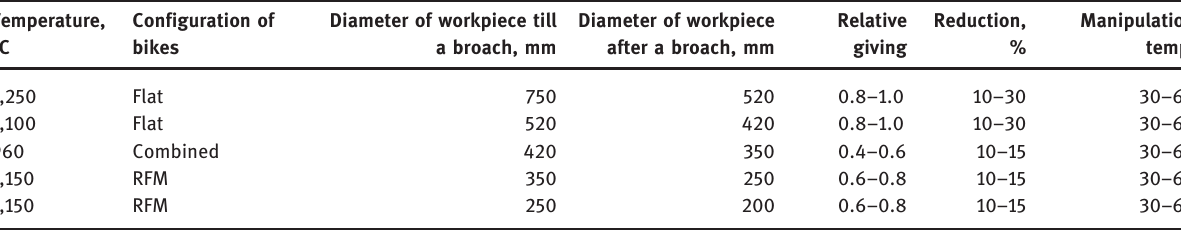
Table 1: Broach modes in ingots from BT9 alloy. Temperature,